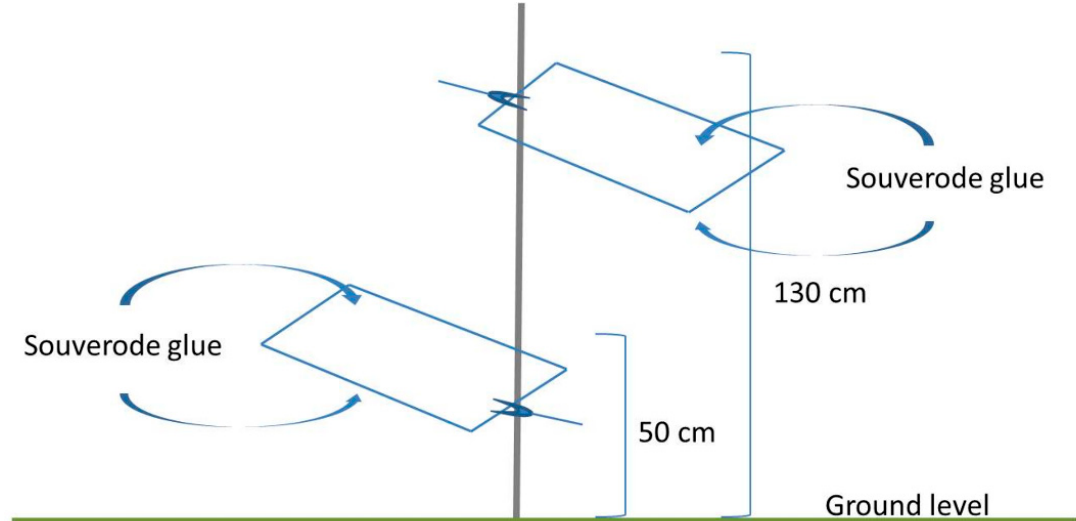
Figure 2. Interception sticky trap. Two plastic surfaces sprayed with Souverode glue. The lower trap was positioned 50 cm above the ground level, the other at 1.3 m above the ground level.